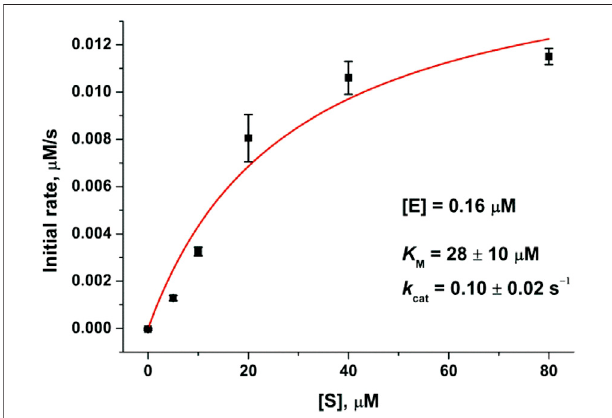
FIGURE 4 | Dependence of the initial rate of substrate cleavage by SARS-CoV-2 M pro . Each data point is an average from at least three independent experiments, the values are presented as the mean ± SE.